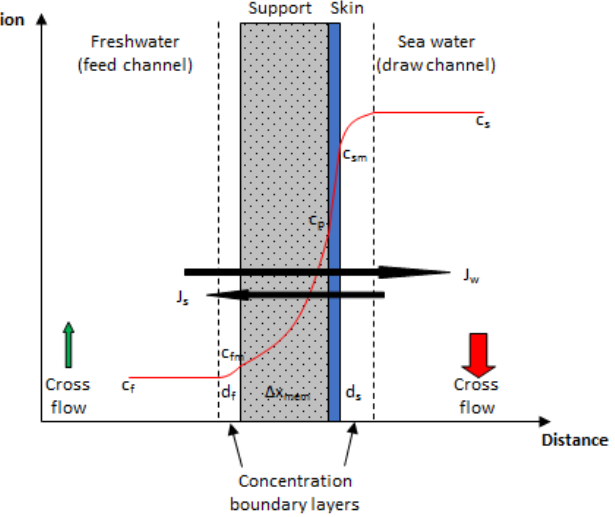
Figure 1. Concentration profile over a Thin Film Composite (TFC) membrane and the boundary layers in PRO, modified from [24].